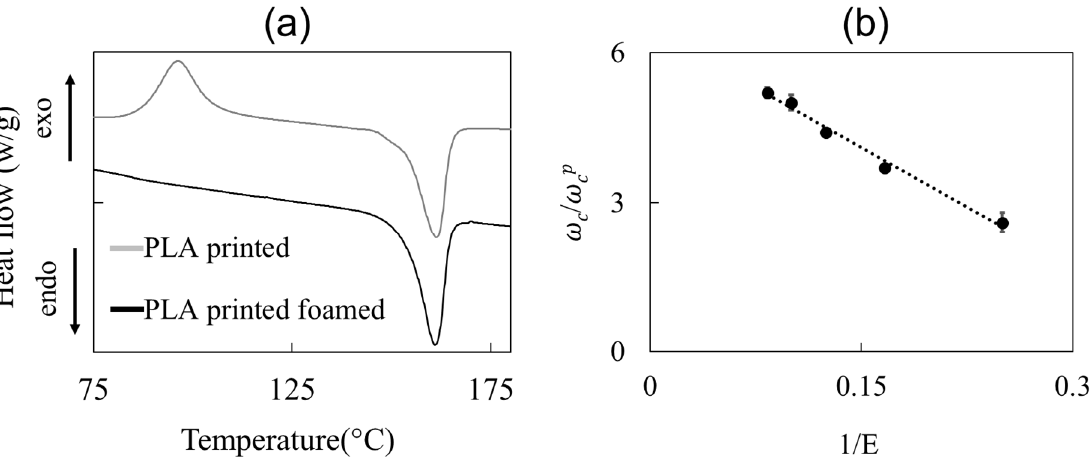
Figure 4. ( a ) Tensile stress as a function of percent deformation for 4 foamed strands at increasing E (see legend); ( b ) Ratio of foam and polymer elastic moduli as a function of the inverse of the expansion ratio. The red line is the best fit of the data at high 1/ E through the power law proposed by Egli et al. [4]; the black curve is the best fit of the data through Equation (1).